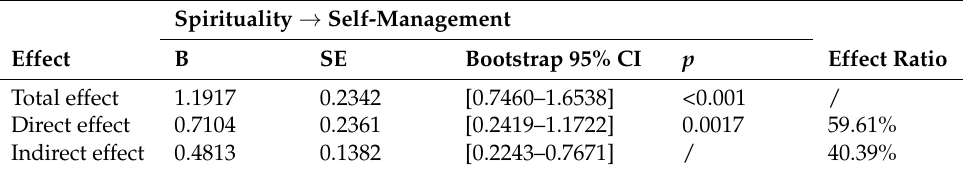
Table 6. Mediating model examination by bootstrap.